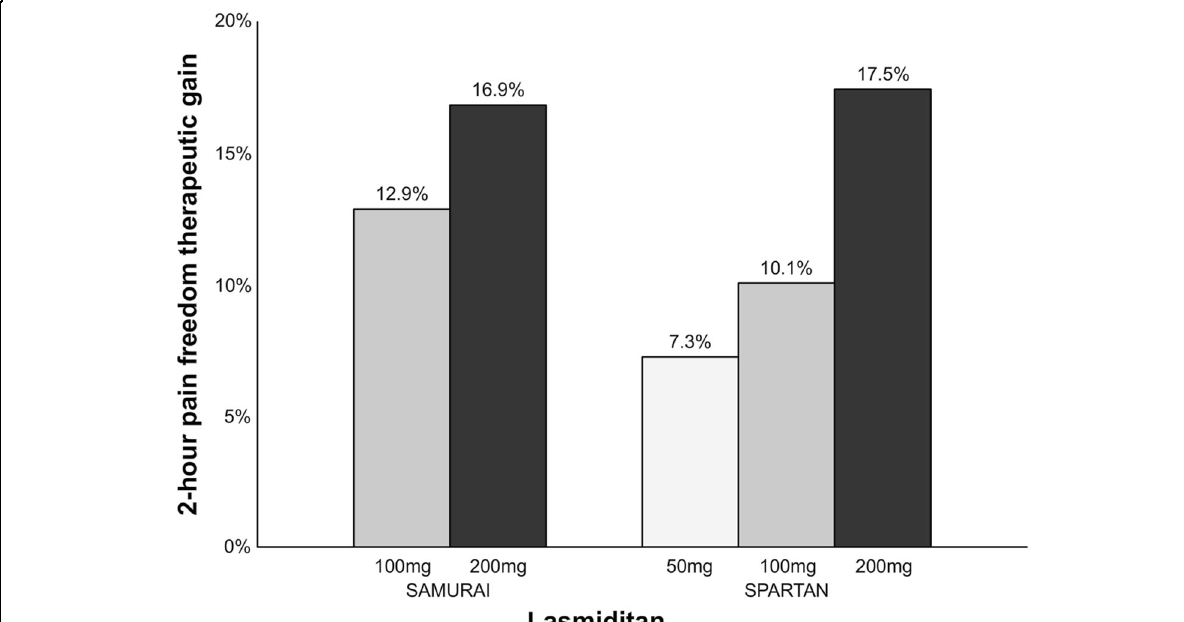
Fig. 2 Overview of the therapeutic gain* in 2-h pain freedom with lasmiditan. A darker bar indicates a higher dose. *Therapeutic gain is defined as the difference between percentage of responders in active group compared to percentage of responders in placebo